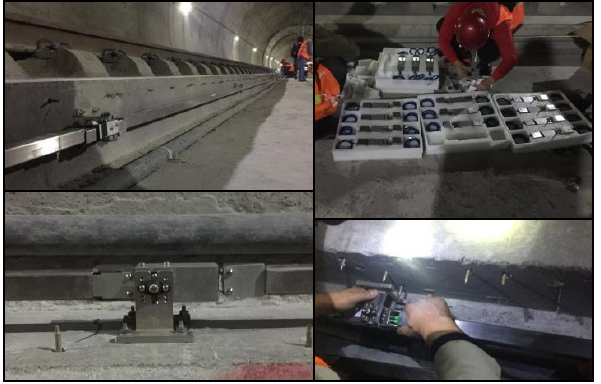
Figure 10. Sensor layout for the monitoring track slabs.